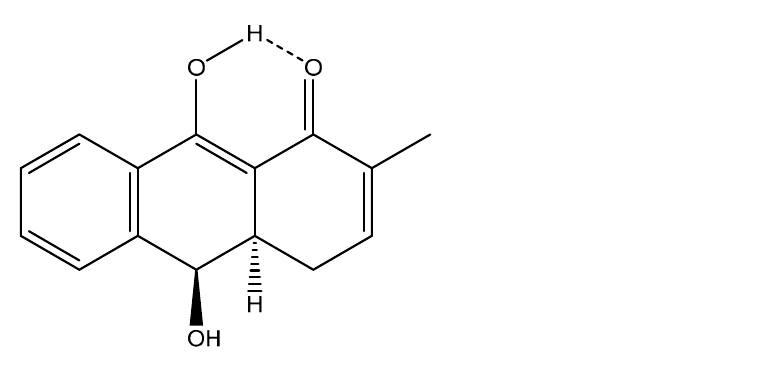
Figure 15. Reutericyclin. ( a ) and ( b ) are two different enolic forms.